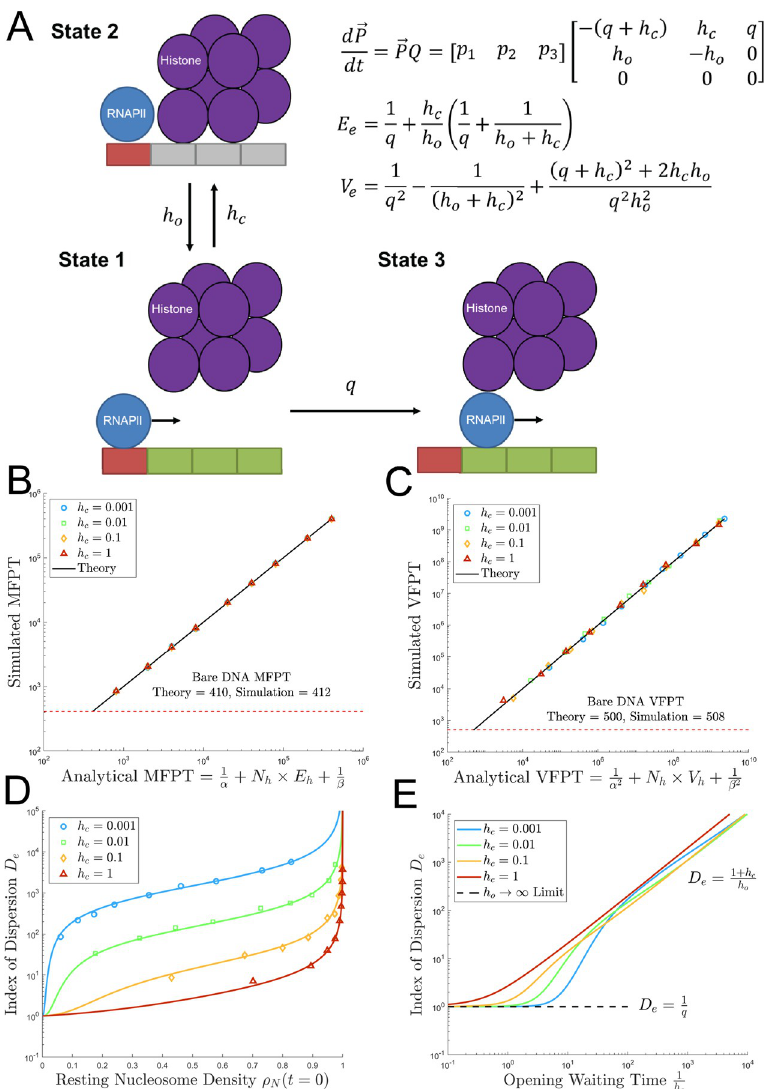
Fig 3. Deriving and validating the mean and variance of first passage time equations. (A) A state transition diagram utilized to calculate the mean ( E e ) and variance ( V e ) of first passage time to enter a nucleosome. Each arrow is labeled with the rate constant for the transition between the neighboring states. (B) Log-log plot of simulated mean first passage time (Eq 22) against the predicted analytical expression for mean first passage time. The black line represents the theoretical prediction. The dashed red line represents the Bare DNA limit obtained by simulations with h c = 0. (C) Log-log plot of simulated variance of first passage time against the predicted analytical expression for VFPT (Eq 26) with the Bare DNA limit represented by the dashed red line. (D) Plot of index of dispersion of the waiting time to enter a nucleosome D = V / E against the resting state binding probability of the nucleosomes ( r ¼ h c ). h is set e e e c N h o þ h c to be 0.001 (blue), 0.01 (green), 0.1 (orange), and 1 (red). h o was adjusted to achieve γ 2 {0.002, 0.005, 0.01, 0.02, 0.05, 0.1, 0.2, 0.5, 0.99}. Solid lines indicate the theoretical prediction given by Eq 27. (E) Log-log plot of the analytical expression for the index of dispersion of the waiting time to enter a nucleosome D e (Eq 27, analytical) as a function of the expected waiting time for nucleosome opening (1/ h ). The dashed black line shows the index of dispersion in the o limit of h o !